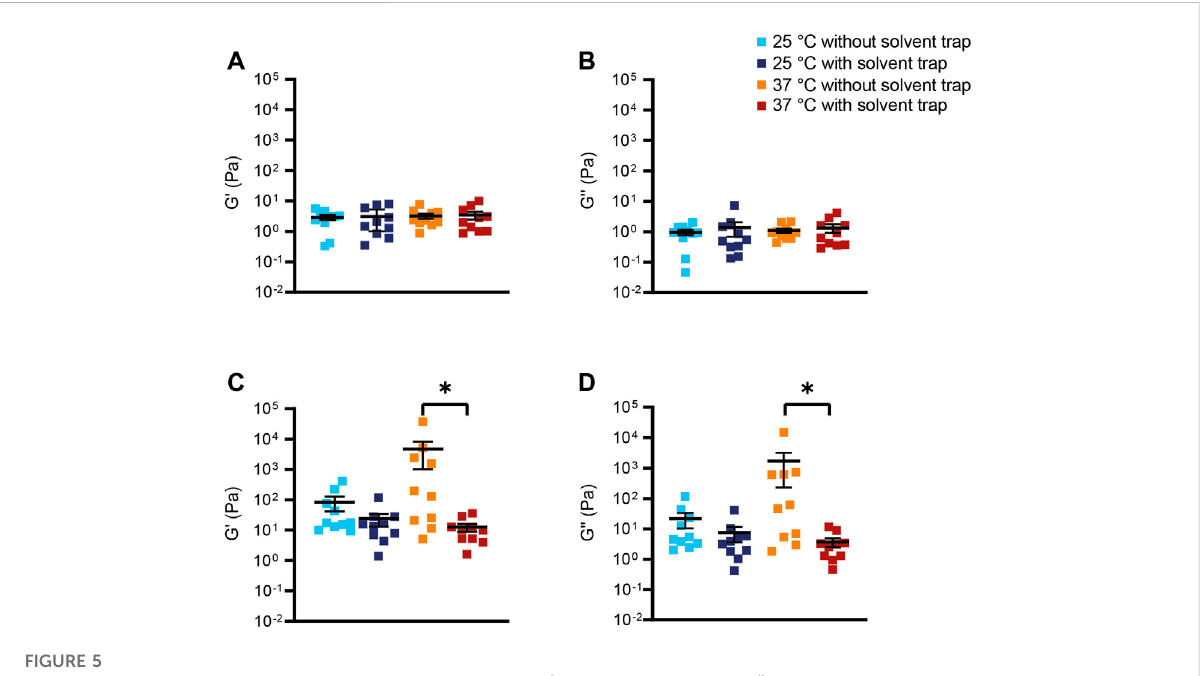
FIGURE 5 Viscoelastic properties of human sputum. (A,C) Storage modulus G ′ and (B,D) loss modulus G ″ of (A,B) sputum from healthy controls ( n = 10) andfrom (C,D) patientswithcystic fi brosis( n =10)weremeasuredatafrequencyof1 Hz.Dataareshownasmean±standarderrorofthemean(SEM) of measurements at 25 ° C and 37 ° C with and without solvent trap; * p < 0.05.